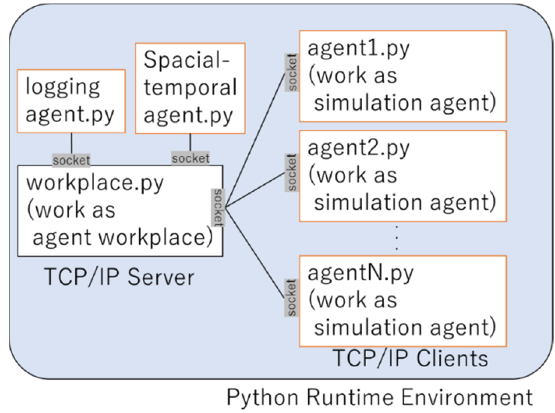
Figure 7. Composition of prototyped multi-agent modelling environment.